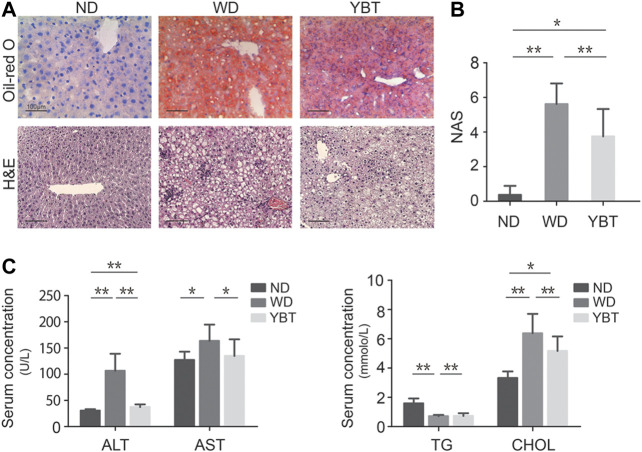
Yiqi-Bushen-Tiaozhi (YBT) ameliorated hepatic steatosis and inflammation in mice induced by WD. (A). Representative Oil-red O stained (top line) and H&E stained (bottom line) liver sections (Scale bar = 100 μm). (B). NAFLD activity score (NAS) evaluation of ND, WD and YBT groups. (C). Serum concentrations of ALT, AST (left) and TG, CHOL (right). ND, normal diet for 16 weeks; WD, Western diet for 16 weeks; YBT, Western diet for 16 weeks combined with YBT treatment for 12 weeks. Results are shown as mean ± SD (n = 8). *p < 0.05, **p < 0.01.